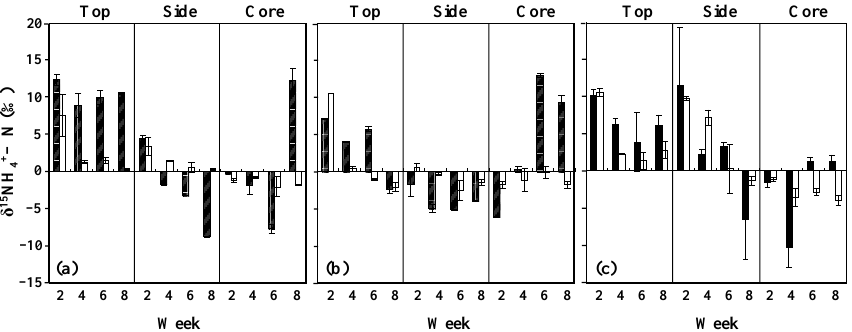
Figure 3. δ 15 N of NH + –N of the samples from each compost location (pile top, side and core). The values were expressed as the difference 4 from the mixed samples just after the turning events. The black bars indicate the compost with bulking agent (10% w/w ), and the white bars indicate the compost without bulking agent. (a) – (c) indicate the compost runs 1–3. The error bars indicate the standard deviation ( n = 3).